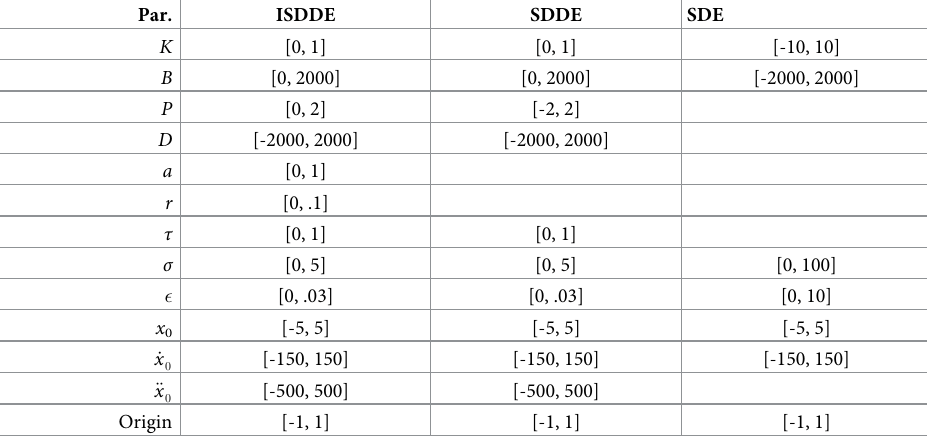
B could not be less than zero in the ISDDE because it is conjectured to represent ankle stiff- ness, and stability is required to come from values of P and D in the given domains. In the SDE, stable solutions must rely on only instantaneous feedback with coefficients K and B . In the absence of other theoretical mechanisms, the same physiological interpretations of K and B could not be assumed and thus the same theoretical constraints were not applied. Multiple regression was used to test the association between each parameter, visual feed- back, and age, accounting for height and mass as covariates. Pearson correlation was used to estimate the correlation between parameter estimates during trials with eyes open and trials with eyes closed. Maximum likelihood estimation was used to fit each model, assuming the multivariate normality of measurement and process noise. Table 6. Optimization boundaries [lower, upper] for each parameter, under each model. Par.